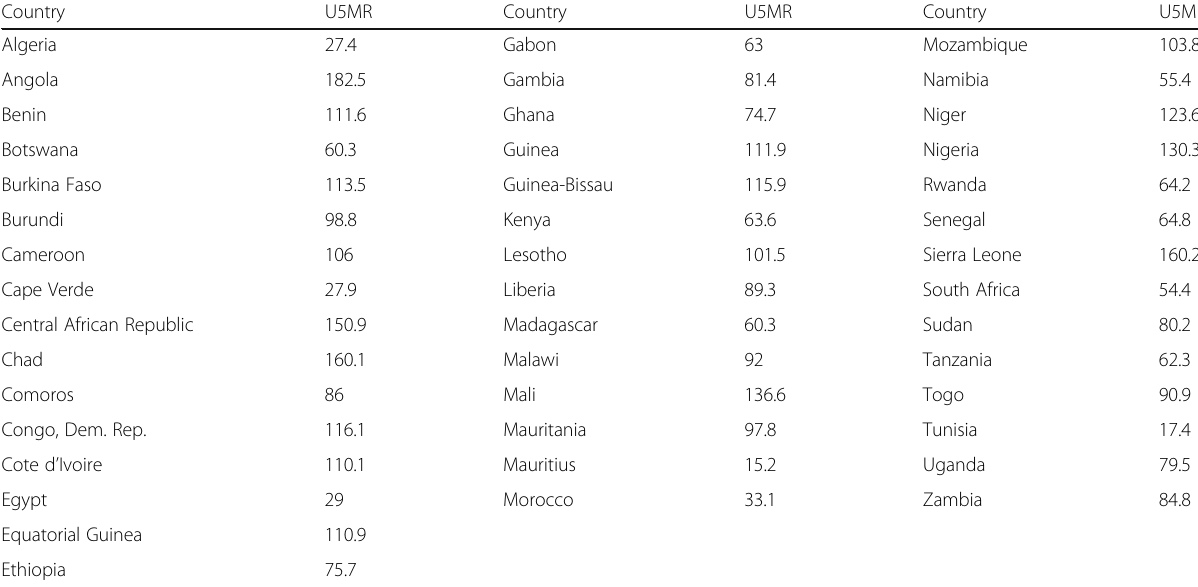
country U5MR differentials within Africa, as well as de- termine the factors that account for the differences between the UNICEF-8 and the rest of the countries on Table 1 2010 under-five mortality rates (per 1000 live births) in African countries considered in this study (UN IGME, 2016) Country